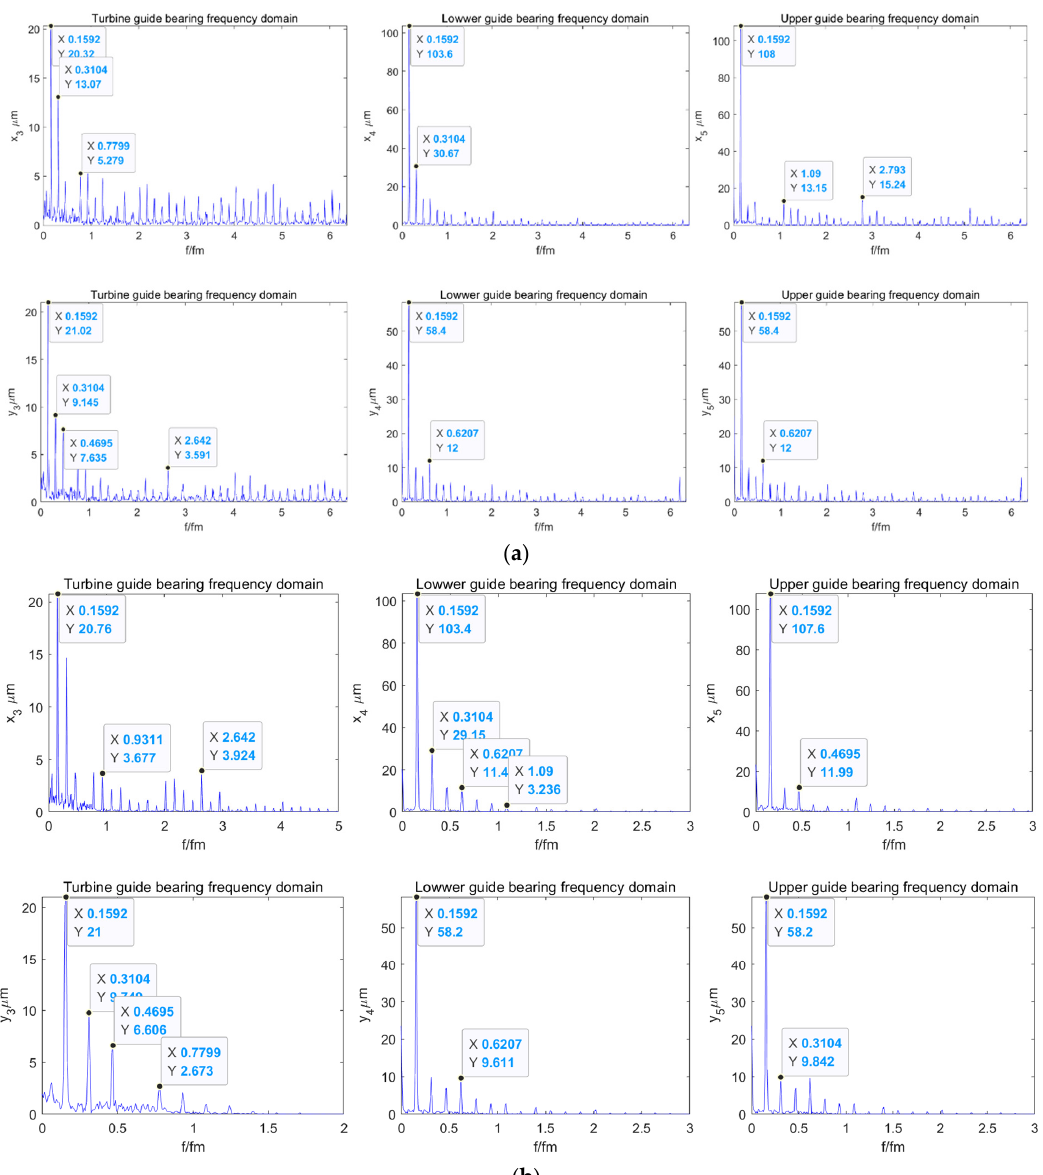
Figure 9. Spectrum diagram of the shafting vibration: ( a ) Spectrum diagram before shafting vibration denoising, ( b ) Spectrum diagram after shafting vibration denoising